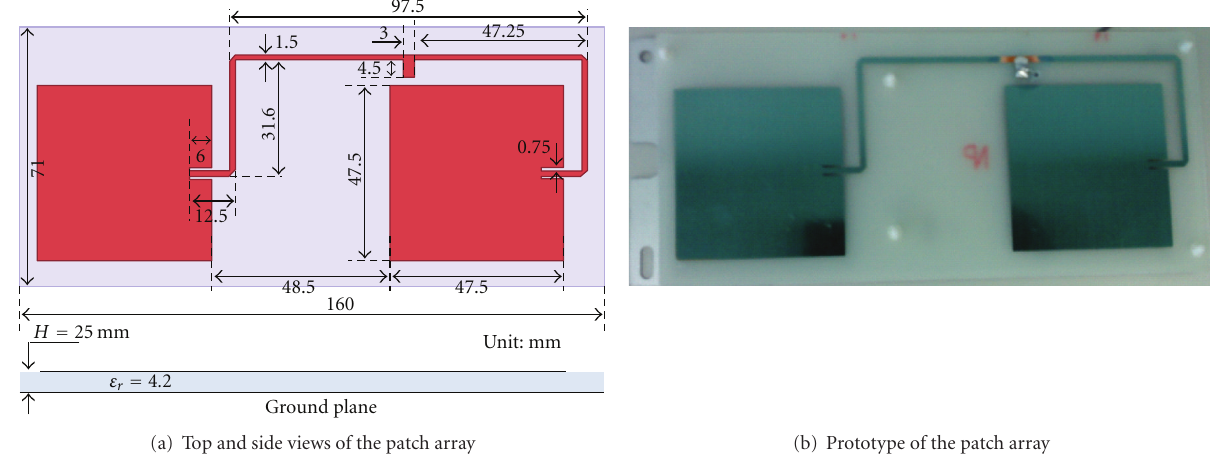
Figure 14: Configuration of a patch array and the prototype. (a) Configuration of the patch array; (b) prototype of the patch